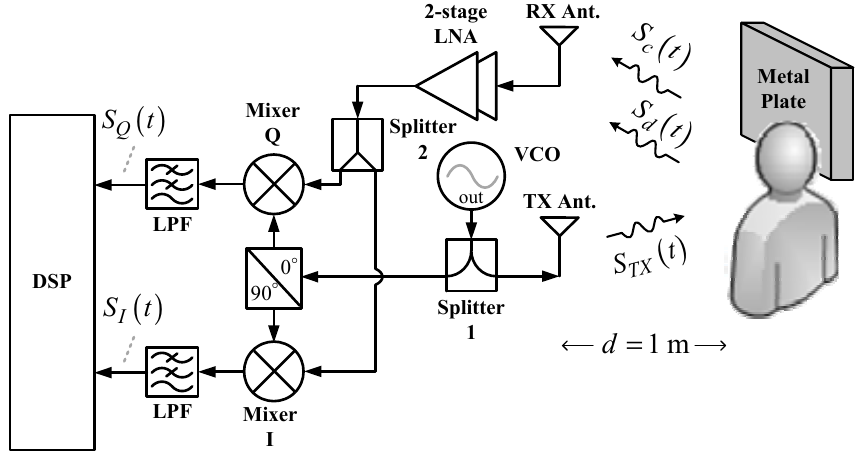
Figure 1. Conventional CW radar for non-contact vital sign monitoring.